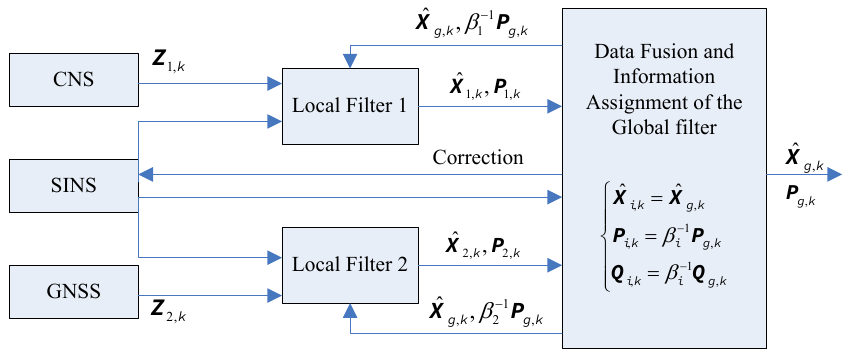
Figure 1. Federated filter structure of SINS/CNS/GNSS integrated